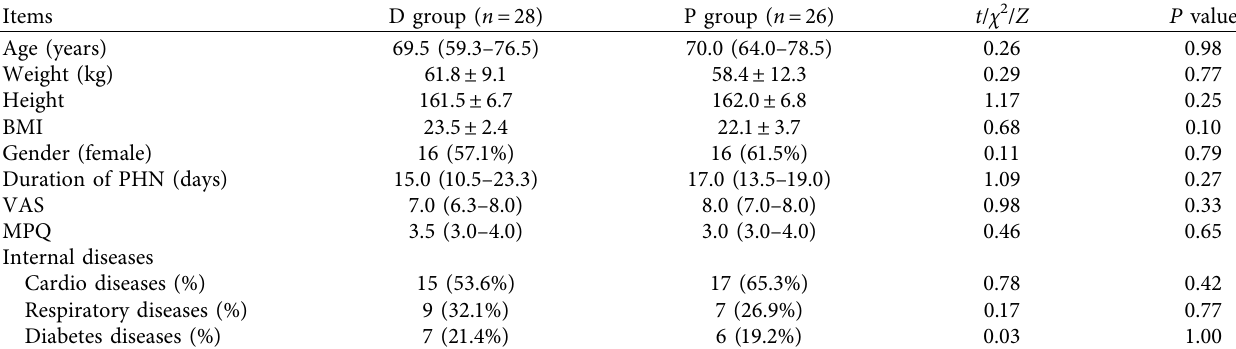
Table 1: Comparison of the baseline level and the clinical